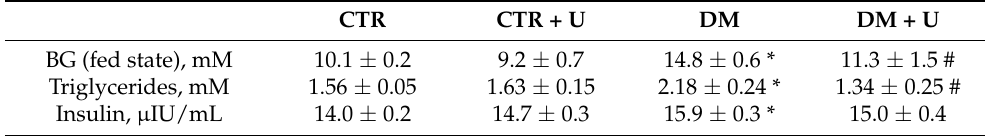
Table 1. Biochemical characteristics of the blood of mice in the experimental groups. CTR CTR + U DM DM + U BG (fed state), mM 10.1 ± 0.2 9.2 ± 0.7 14.8 ± 0.6 * 11.3 ± 1.5 # Triglycerides, mM 1.56 ± 0.05 1.63 ± 0.15 2.18 ± 0.24 * 1.34 ± 0.25 # Insulin, µ IU/mL 14.0 ± 0.2 14.7 ± 0.3 15.9 ± 0.3 * 15.0 ±